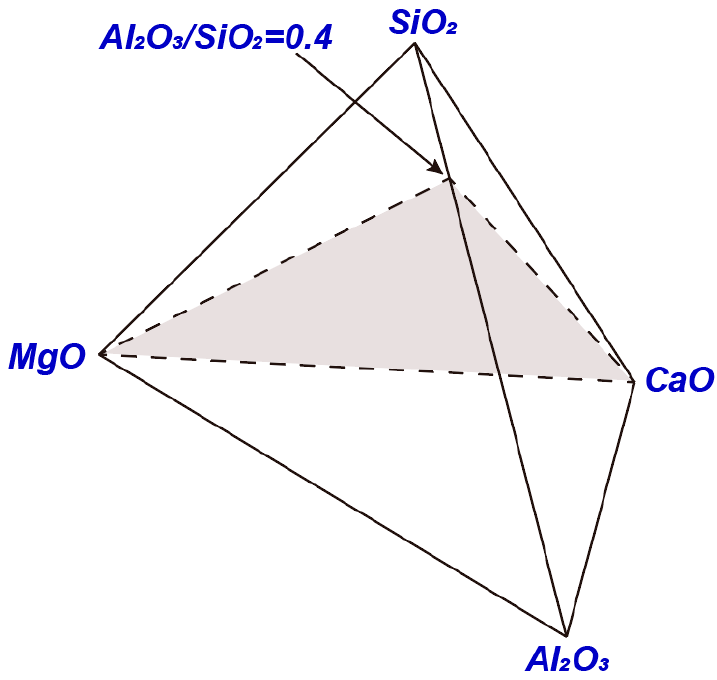
Figure 13. Representation of the pseudo-ternary phase diagram CaO-MgO-(Al 2 O 3 + SiO 2 ) at constant Al 2 O 3 /SiO 2 ratios [22].